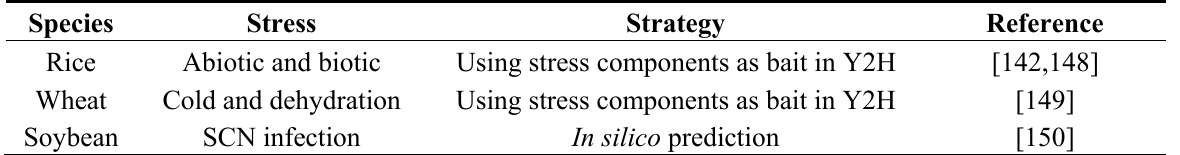
Table 6. Recent large-scale stress interactome studies in crop